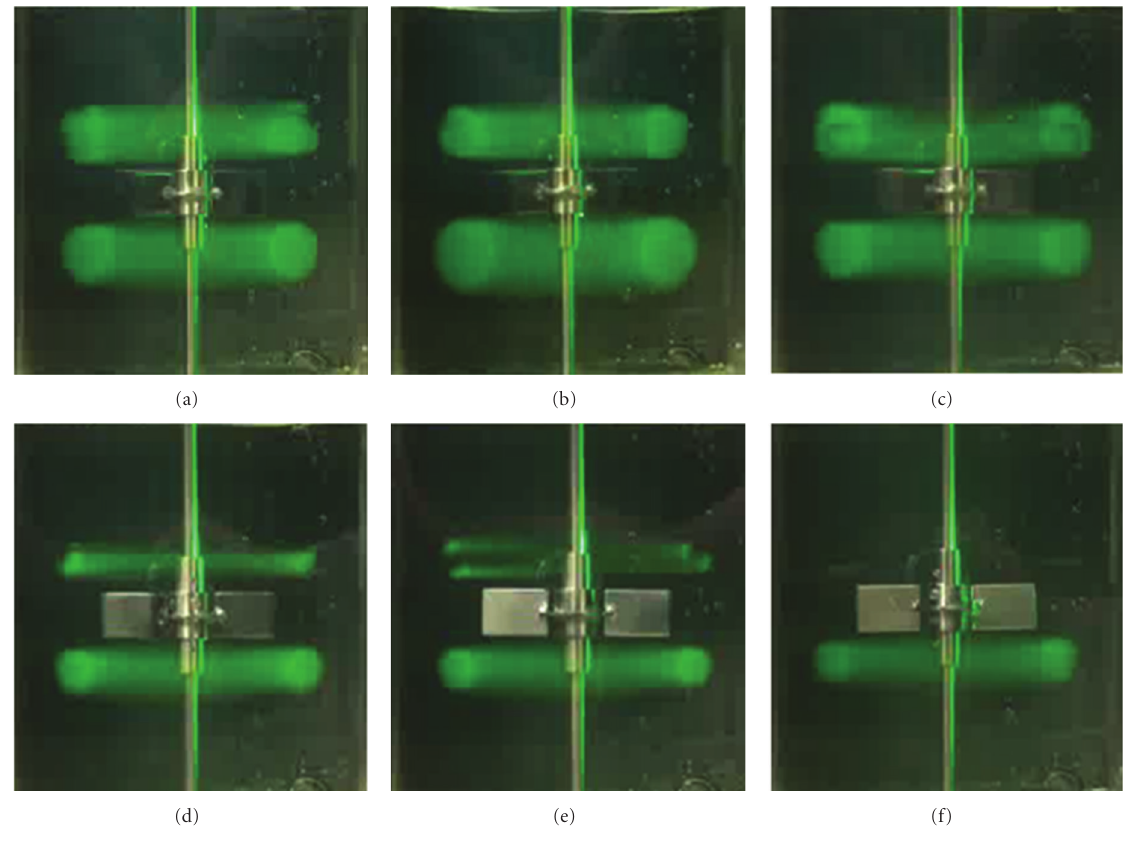
Figure 3: Overviews of IMR transition, Δ T = 10